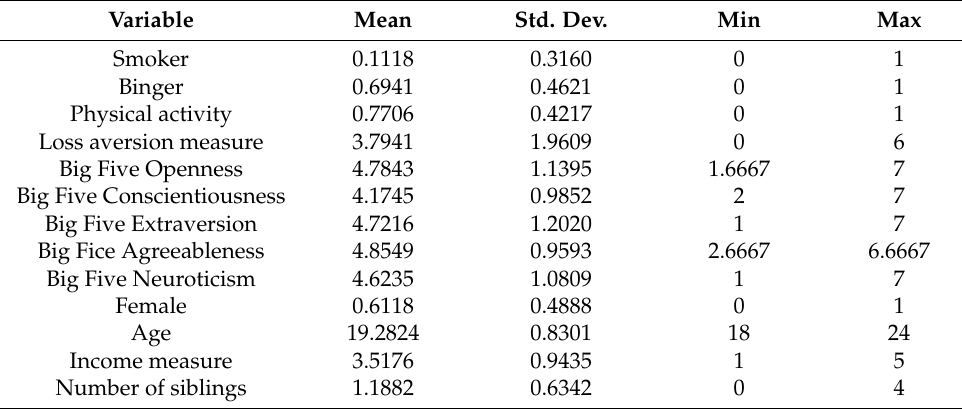
Table 2. Summary statistics, Korean sample.